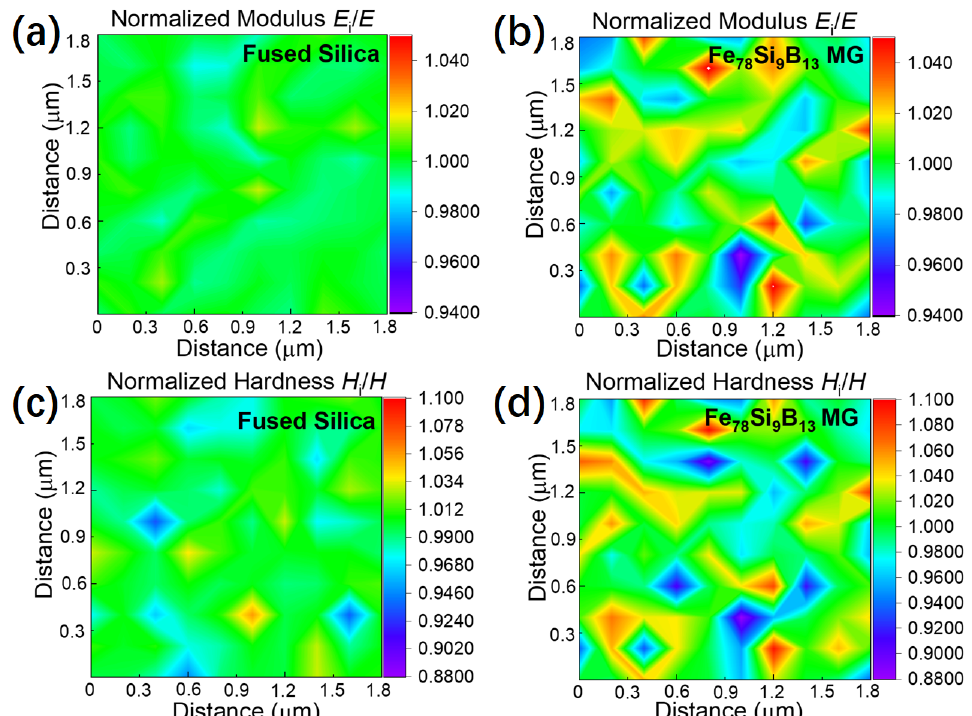
Figure 7. The 2D distribution of mechanical properties obtained via nanoindentation mapping. Nor- malized elastic modulus E i / E distribution maps of ( a ) fused silica and ( b ) Fe 78 Si 9 B 13 MG. Normalized hardness H i / H distribution of ( c ) fused silica and ( d ) Fe 78 Si 9 B 13 metallic glass. All the data were nor- malized using their average values ( E or H ) in the 2D mapping. A 10 × 10 array indentation mapping was employed with a spacing ( d ) of 200 nm and a maximum depth ( h ) of 20 nm across a region of 1.8 × 1.8 μ m 2 . The variations of both elastic modulus and hardness are shown using the color scales.